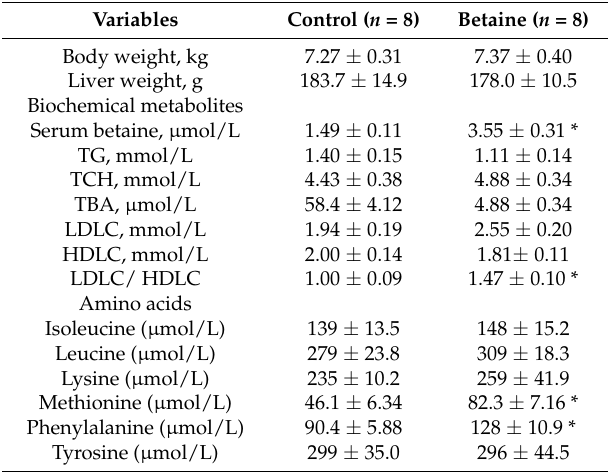
Values are means ± SEM, n = 8. Different from control, * p < 0.05.